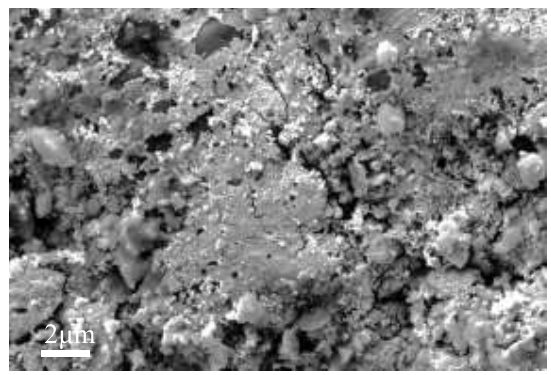
Figure 7: The SEM micrograph in the absence of the corrosion inhibitor for mild steel